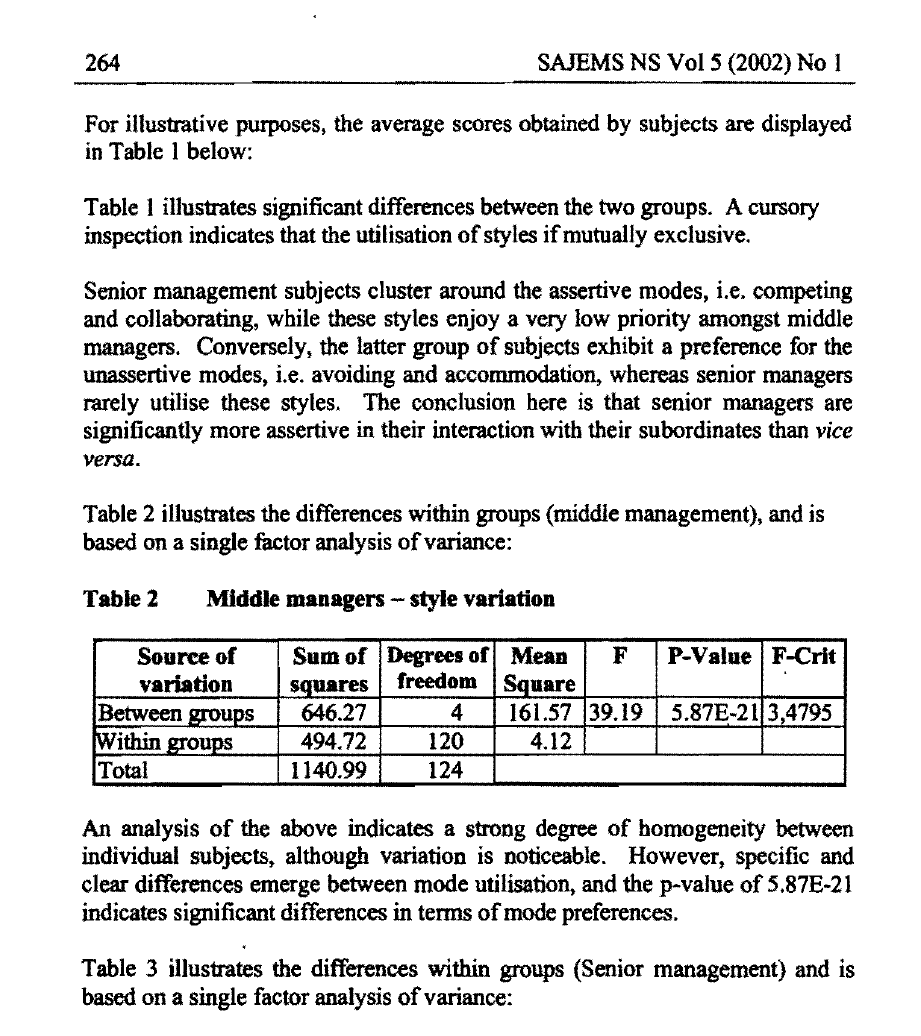
Middle managers - style variation Source of Sum of Degrees of Mean F P-Value F-Crlt variation squares freedom Square Between groups 646.27 4 161.57 39.19 I 5.87E-21 34795 Within groups